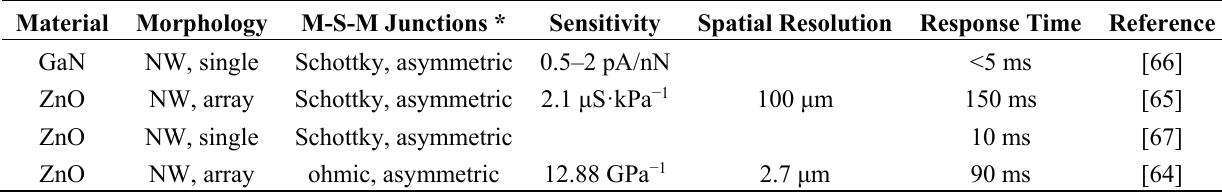
Table 2. A comparison of force and pressure sensing